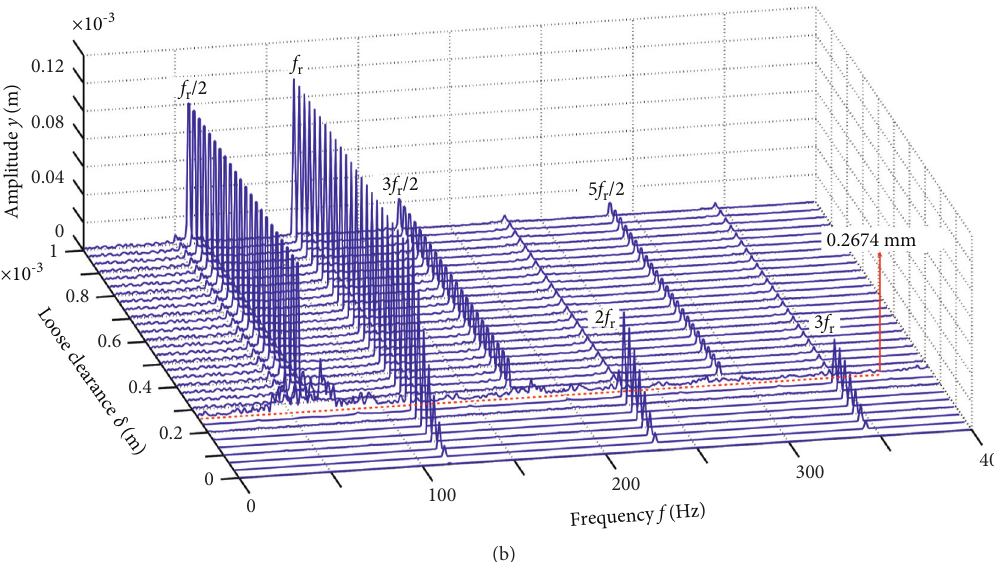
Figure 14: Spectrum cascades of the system with the change of the loose clearance. (a) Spectrum cascade of right journal. (b) Spectrum cascade of right bearing